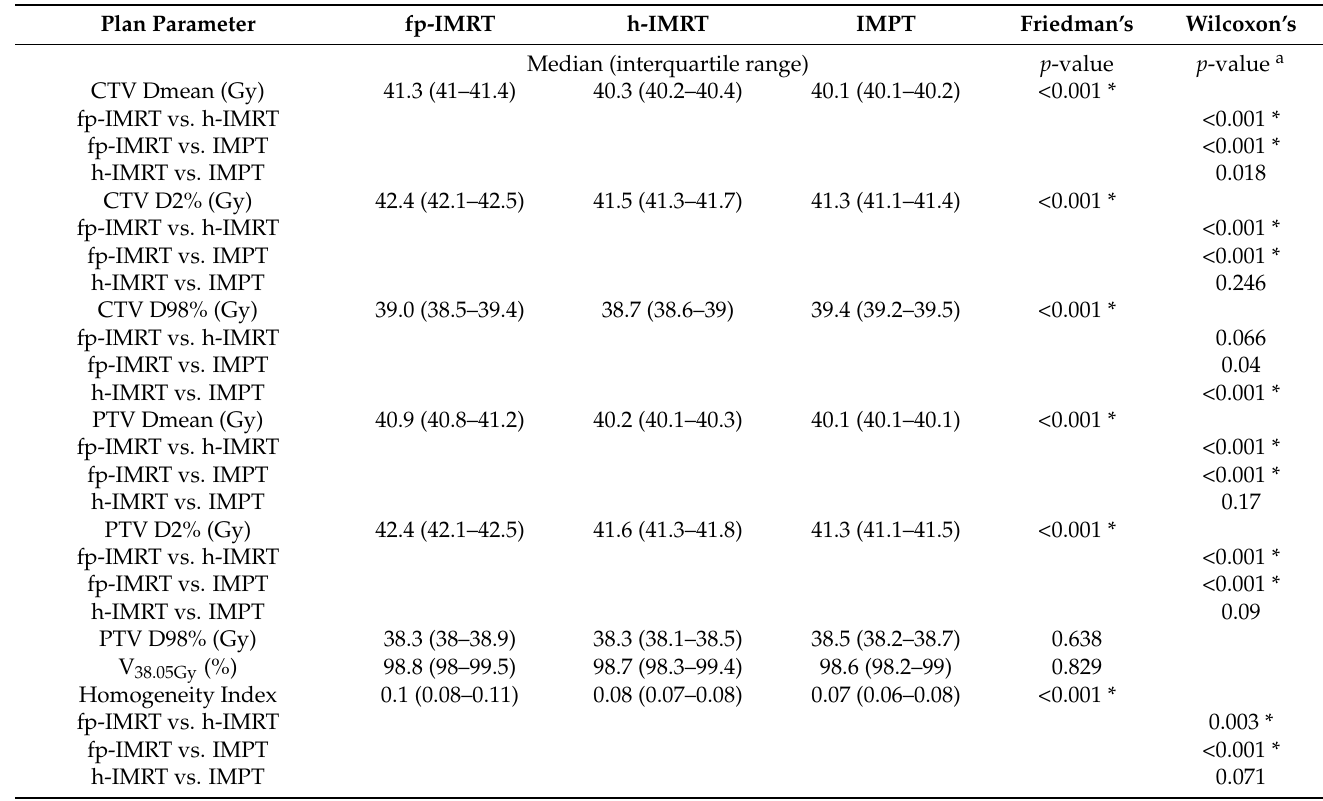
Table 2. Differences in target volume parameters between fp-IMRT, h-IMRT, and IMPT plans, n = 16 Plan